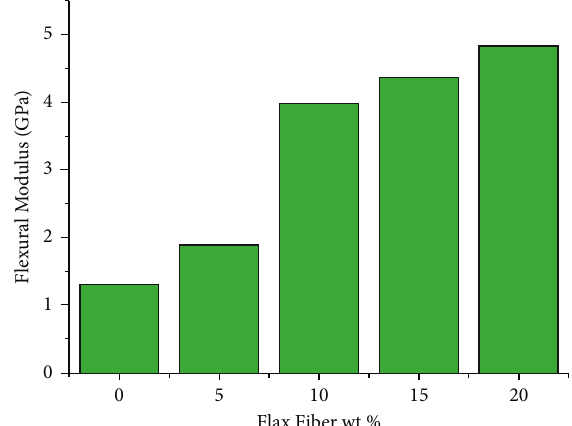
Figure 8: Effect of flax fibre content on flexural modulus of pure and hybrid composites.